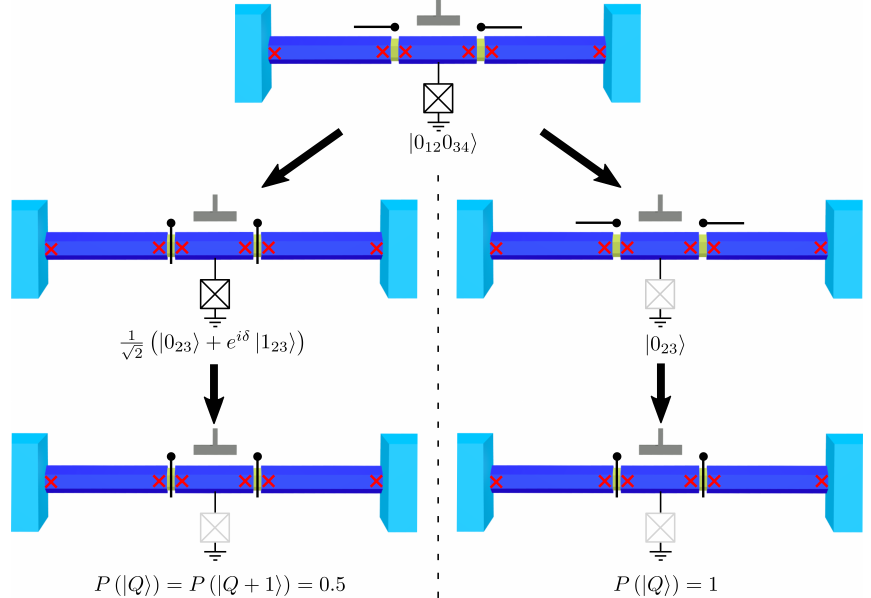
Figure 2: Fusion (left) and reference (right) protocols. Initially, the island is con- nected to the leads and charging effects are quenched by opening the JJ FET. In the fusion protocol, the cutter gates are first closed (indicated by the black vertical lines cutting the TS wires), and then the JJ FET is closed (indicated by a faded symbol). In the reference protocol, the JJ FET is closed before the cutter gates. At the end, the island is isolated. In the reference protocol the isolated island always ends up in the ground state (charge Q ). In the fusion protocol the isolated island ends up in either the ground state (charge Q ) or first excited state (charge Q + 1) with equal